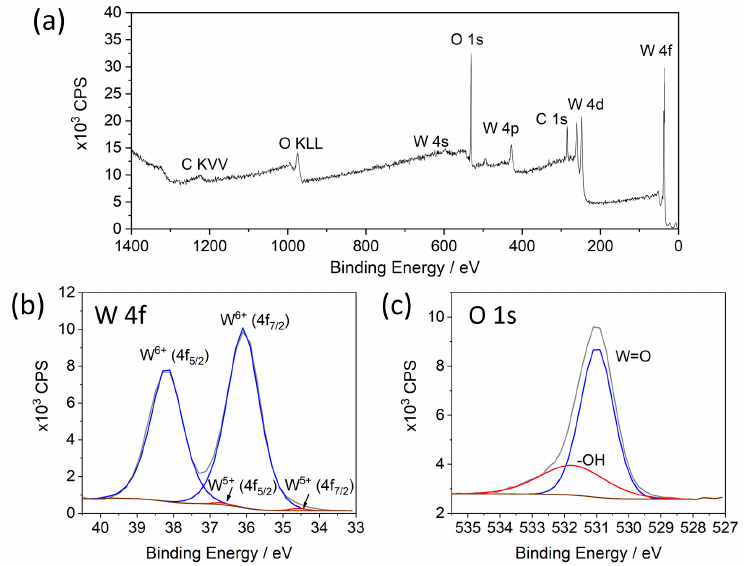
Figure 4. Full scan ( a ), range of W 4f ( b ) and range of O 1s ( c ) of an XPS spectrum measured at a WO 3| µp600 thin film.